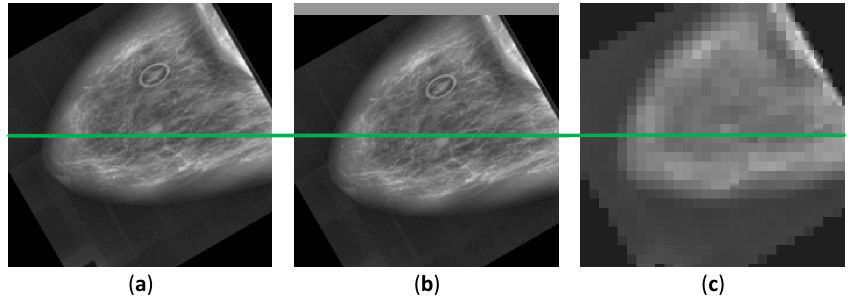
Figure 15. Demonstration using DDSM right breast masses benign cancer with CC view to present the comparison among ( a ) original, ( b ) vertical translation, and ( c ) JPEG compressed images with a green line indicating the image vertical center.